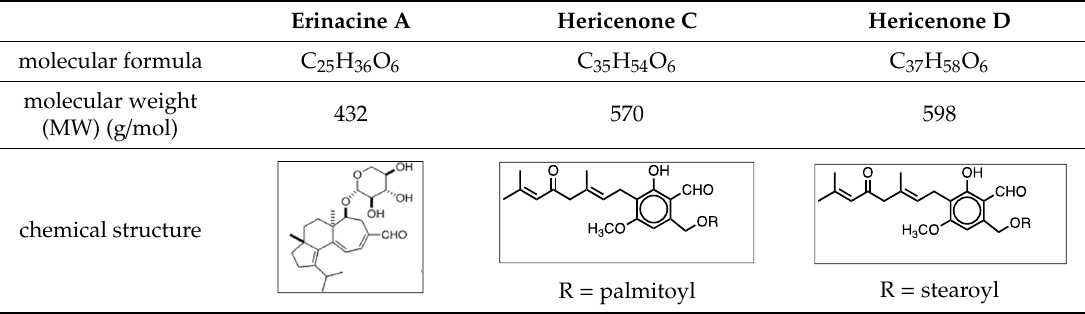
Table 2. Molecular formula, chemical structures, and molecular weights of erinacine A and hericenones C and D.